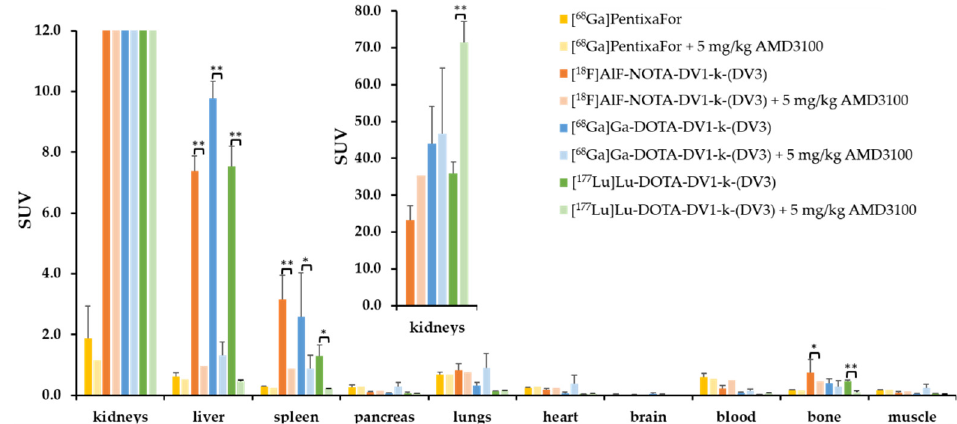
Figure 2. ( A , B ) Positron emission tomography (PET)/computed tomography (CT) imaging in wild-type mice. Averaged maximum intensity projection (MIP) image (50–60 min post-injection (p.i.)): ( A ) [ 18 F]AlF-NOTA-DV1-k-(DV3) ( n = 5), ( B ) [ 18 F]AlF-NOTA-DV1-k-(DV3) + 5 mg/kg AMD3100 ( n = 2). ( C ) Time-activity curves (TACs) expressed in mean standardized uptake value (SUV mean ) (SUV averaged over organ volume) for kidneys and liver. All data are expressed as mean ± SD.